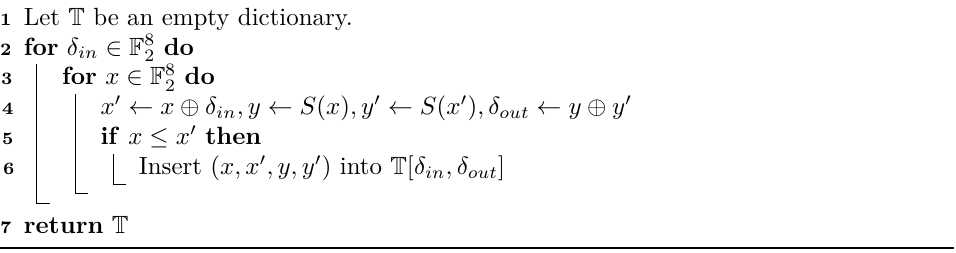
Algorithm 1: The differential distribution table of S with data